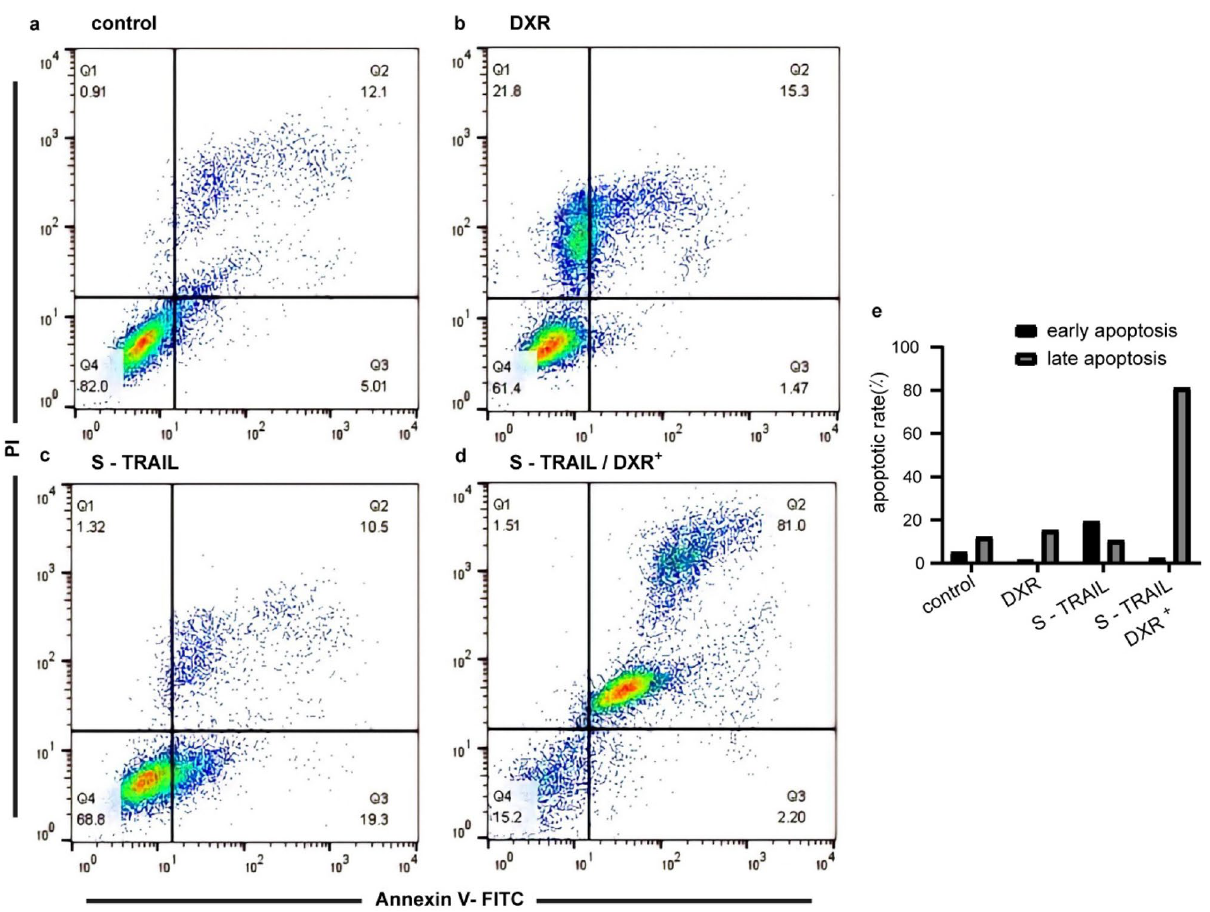
Figure 7. Evaluation of apoptosis induction in HT-29 cells. ( a ) Control cells without any treatment. ( b ) The cells treated with DXR (0.1 µM) for 24 h. ( c ) Treatment with S-TRAIL (160 µg/ml) for 12 h and ( d ) the cells pretreated with DXR (0.1 µM) for 24 h followed by treatment with S-TRAIL (160 µg/ml) for 12 h. ( e ) Quantitative comparison of the apoptosis rate of the cells.